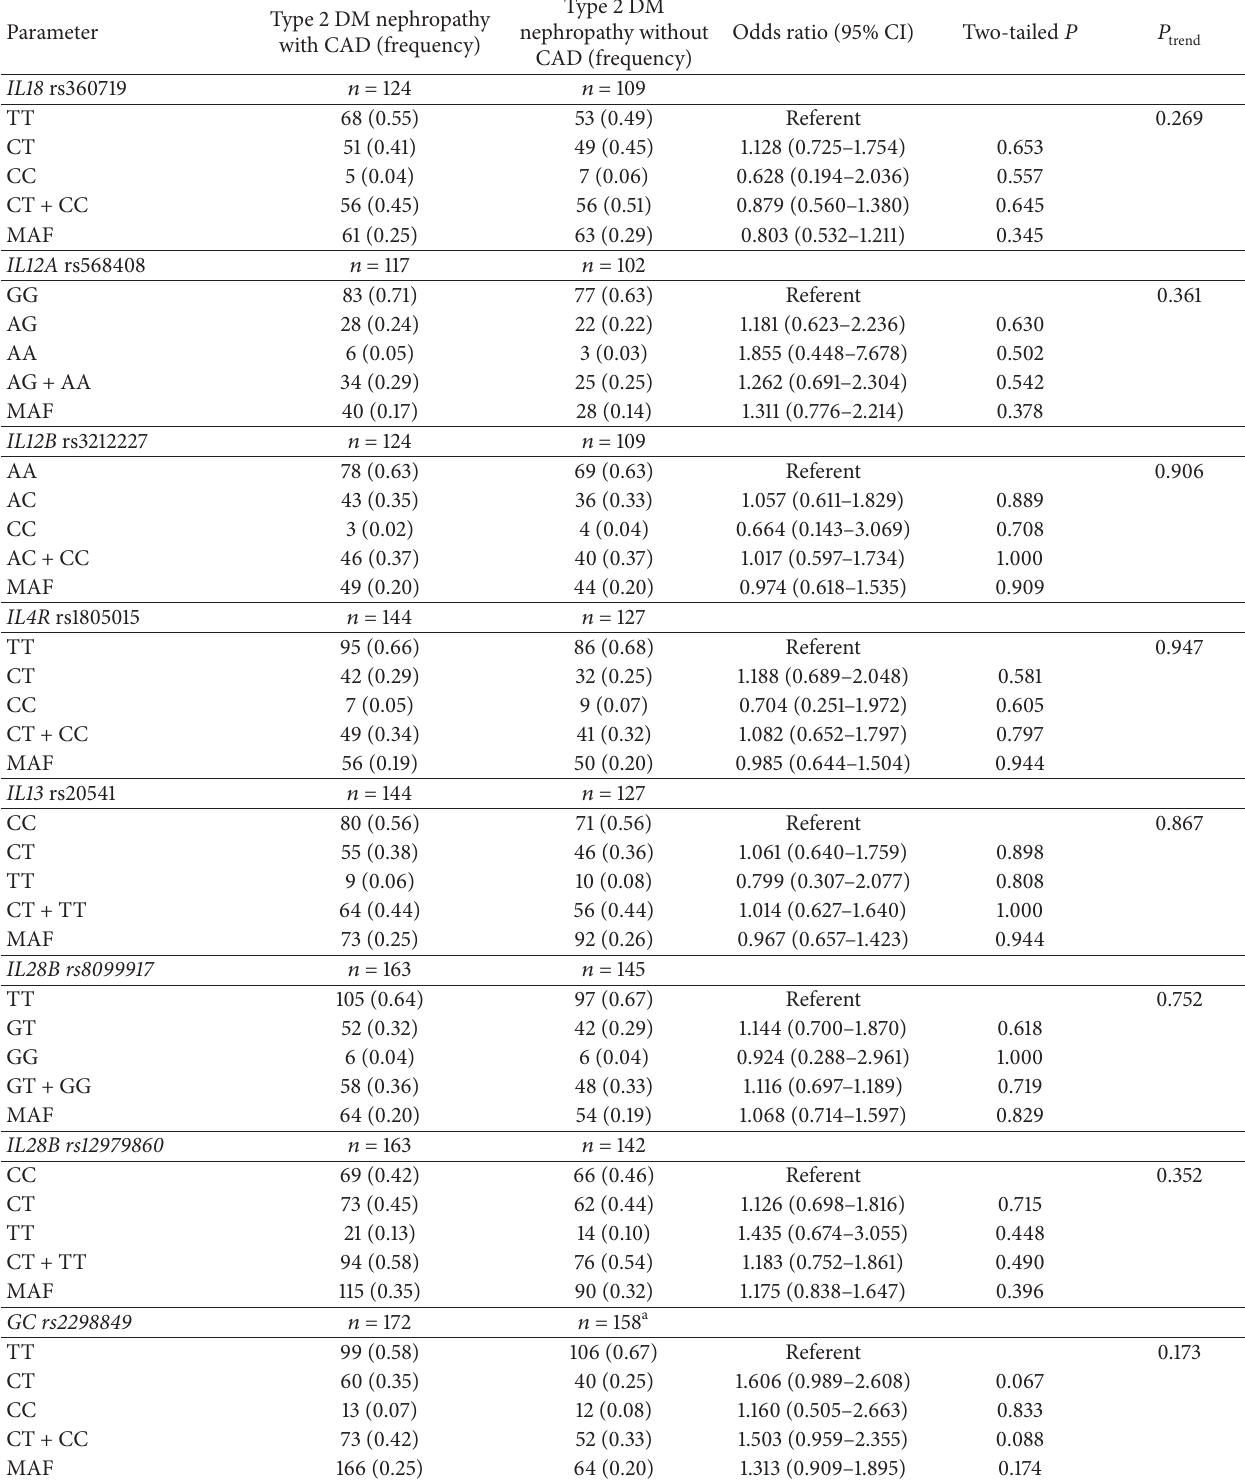
Table 7: Comparison of the distribution of polymorphic variants of tested genes between ESRD patients treated with hemodialysis due to type 2 DM nephropathy grouped by diagnosis of